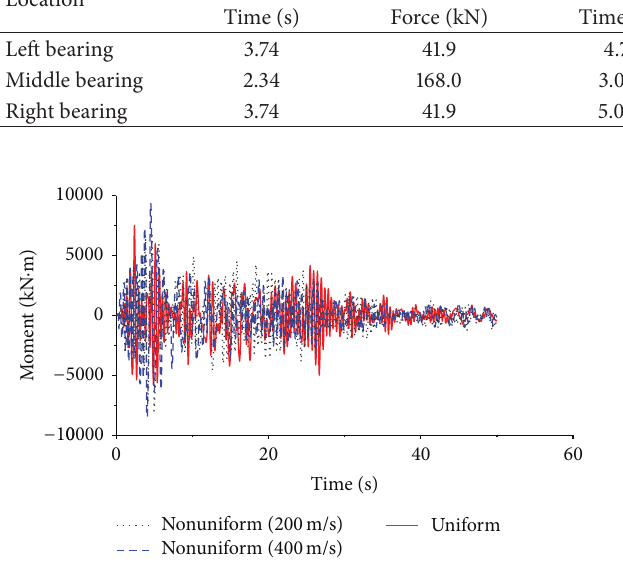
Figure 11: Time histories of moment force at the bottom of RC pier.